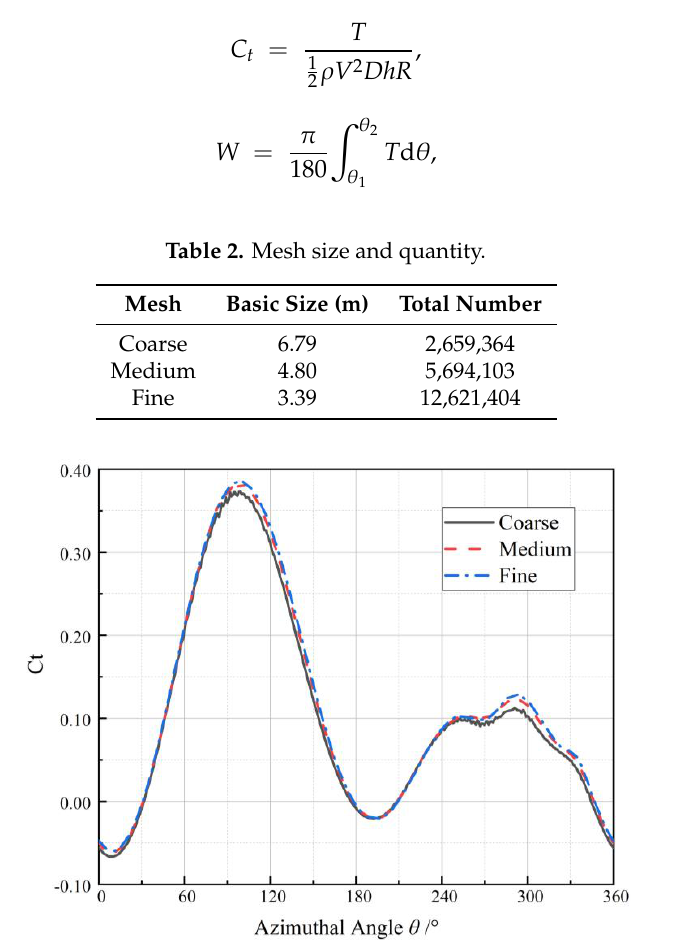
Figure 5. Instantaneous torque of a blade under three mesh